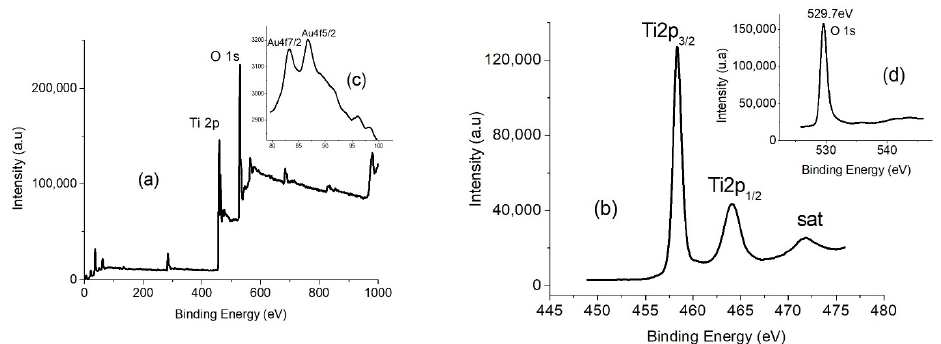
Figure 3. X-ray photoemission spectroscopy (XPS) peaks of ( a ) convoluted spectra of Ti 2p, O 1s, and Au 4f; ( b ) deconvoluted Ti 2p spectra; ( c ) deconvoluted Au 4f spectra; and ( d ) deconvoluted O1s spectra.